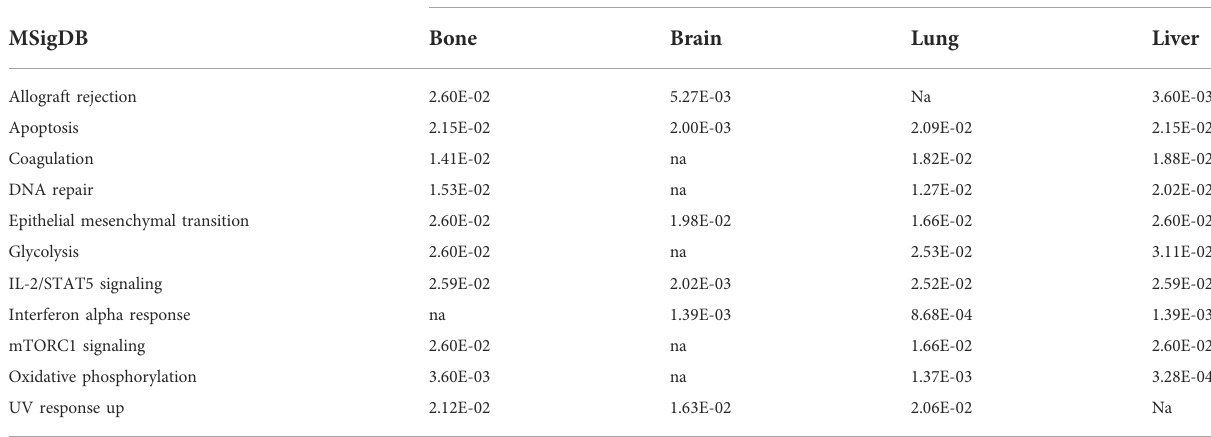
TABLE 2 MSigDB enrichment